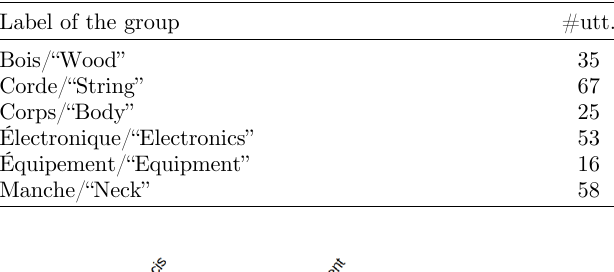
Table 7. Number of utterances (abbr. #utt.) for each group of guitar parts in the corpus.